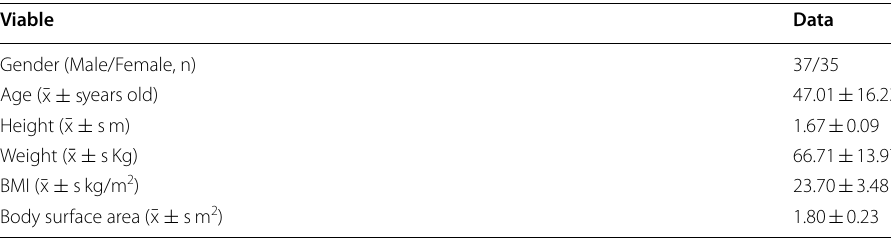
Table 1 General clinical data of the